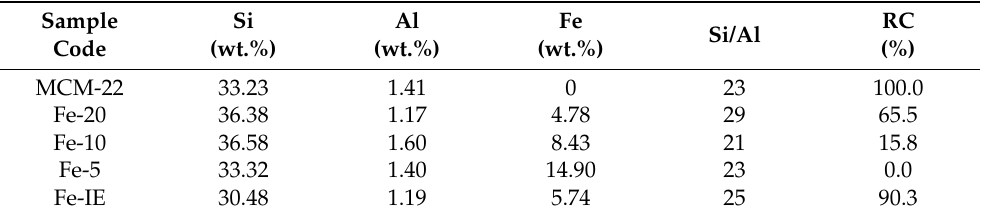
Table 2. Chemical composition and relative crystallinity of the